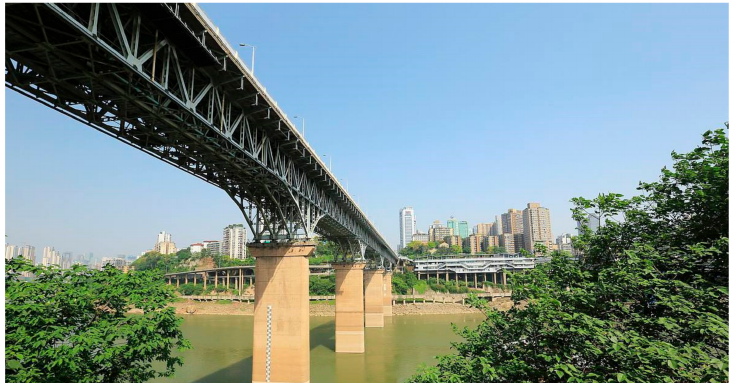
Figure 1. Partial image of the bridge.